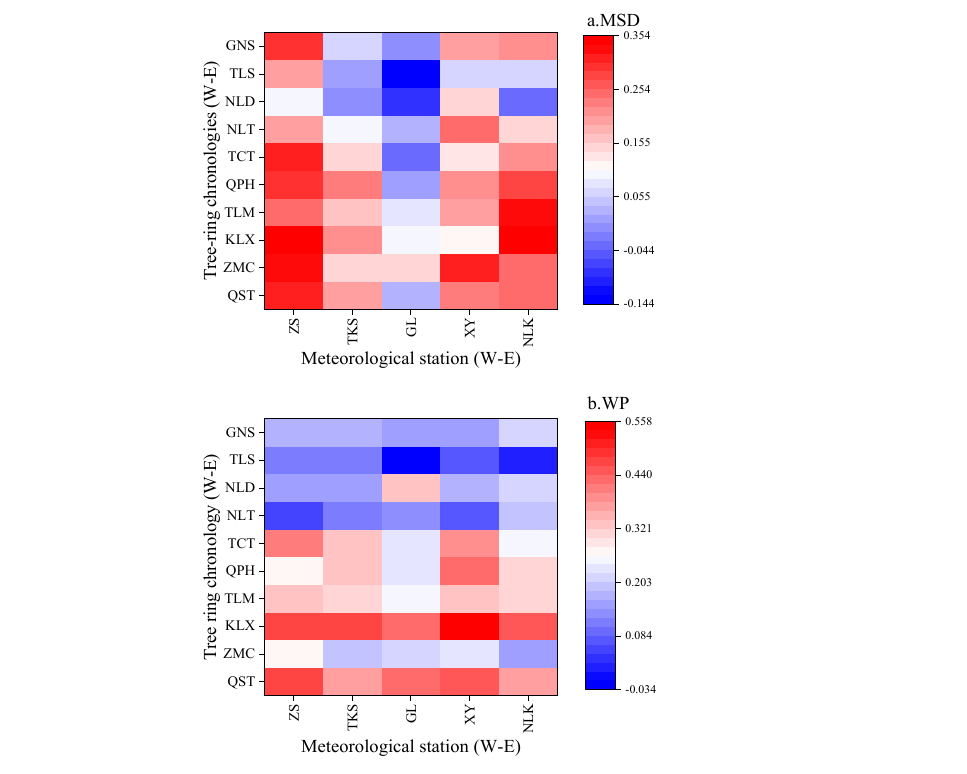
Figure 5. ( a ) Heat map of the correlations between maximum snow depth and tree-ring width in the upper Ili River basin (from west to east); ( b ) heat map of the correlations between precipitation from previous November to current April and tree-ring width in the upper Ili River basin (from west to east). MSD and WP represent maximum snow depth and winter snowfall, respectively.